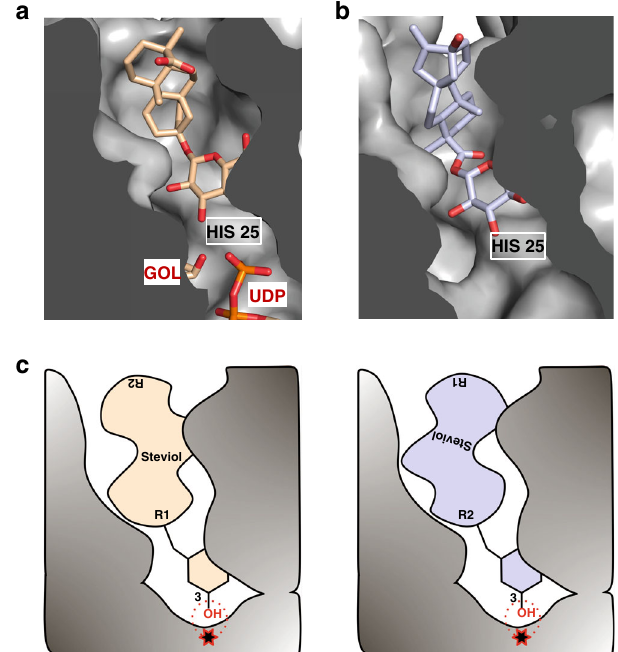
Fig. 6 The two binding modes of the steviol substrates for the sugar transfers. a The normal binding mode for the R1 reaction. The binding mode for the R1 reaction is represented by the ternary complex structure with Rubu, in which the positions of Rubu, GOL, UDP and the catalytic residue His 25 are shown in the cross-section of the binding pocket. b The fl ipped binding model for the R2 reaction. The fl ipped binding mode for R2 reaction is modeled in the ternary complex structure with Reb A, in which the fl ipped steviol glucoside fragment (with carbons colored light purple) stretches the 3-hydroxyl of the glucose AR2 toward the catalytic site without any obvious clash in the binding pocket. c The cartoon representation of the normal and fl ipped binding modes. The catalytic residue His 25 and its reactivation region are represented by a red star and red dots, respectively, toward which the 3-hydroxyl group of either the R1 or R2 position would be